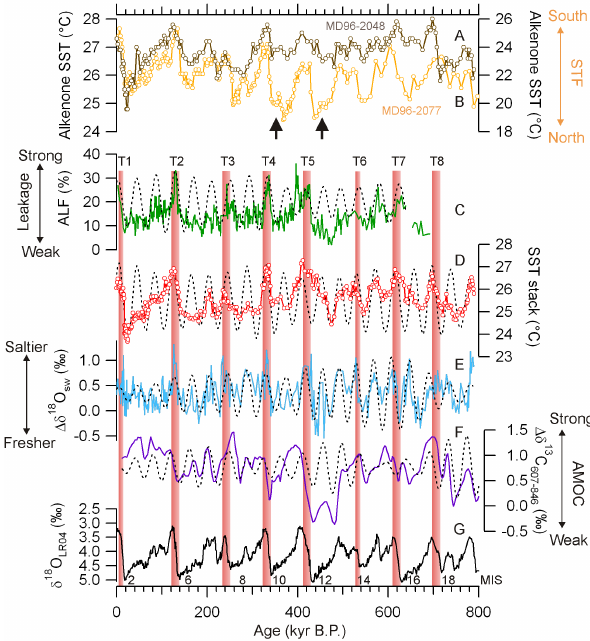
Fig. 6. Relationship between the subtropical front (STF) migra- tion, the Agulhas current strength, the transfer of heat and salt, and 0 the ventilation strength of the AMOC. (A) U K SST record at site 37 MD96-2048. Warmer glacial SSTs are observed in our record when the STF – in (B) – reaches its northern most position (black arrows). 0 (B) U K SST record of MD96-2077, which was used as a proxy 37 of STF migration (Bard and Rickaby, 2009). (C) Agulhas leakage fauna (ALF) record from core MD96-2081, a foraminiferal proxy of the Agulhas leakage (Peeters et al., 2004). Note that a new age model for core MD96-2081 was built based on the correlation be- tween the δ 18 O of the benthic foraminifer P. wuellerstorfi and the LR04 stack (Lisiecki and Raymo, 2005) to allow the comparison 0 with our dataset. (D) Stacked record of Mg/Ca, U K , and TEX H 37 86 SSTs at site MD96-2048. (E) Reconstructed 1δ 18 O sw (a proxy of regional sea surface salinity) at site MD96-2048. (F) δ 13 C gradient between the Atlantic (site 607) and the Pacific (site 846) oceans as a proxy for the ventilation strength of the AMOC (Bard and Rickaby, 2009). For (C) – (F) , black dash lines indicate the obliquity compo- nents (frequency 1/41000; bandwidth: 5e-06). (G) δ 18 O of LR04 stack (Lisiecki and Raymo, 2005). T indicates terminations and numbers indicate marine isotopic stages